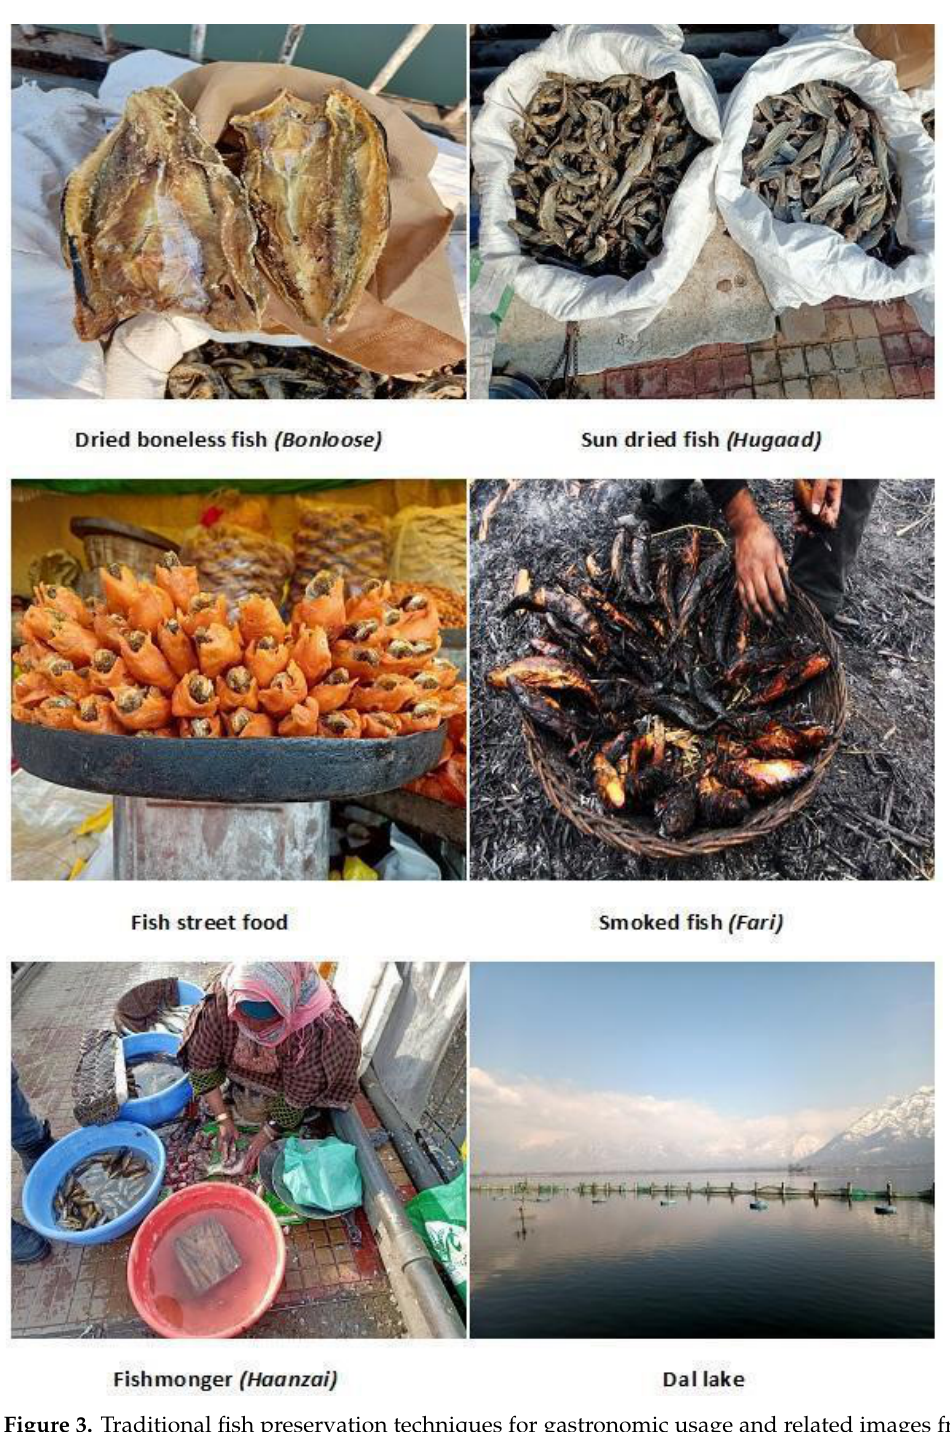
Figure 3. Traditional fish preservation techniques for gastronomic usage and related images from valley of Kashmir.